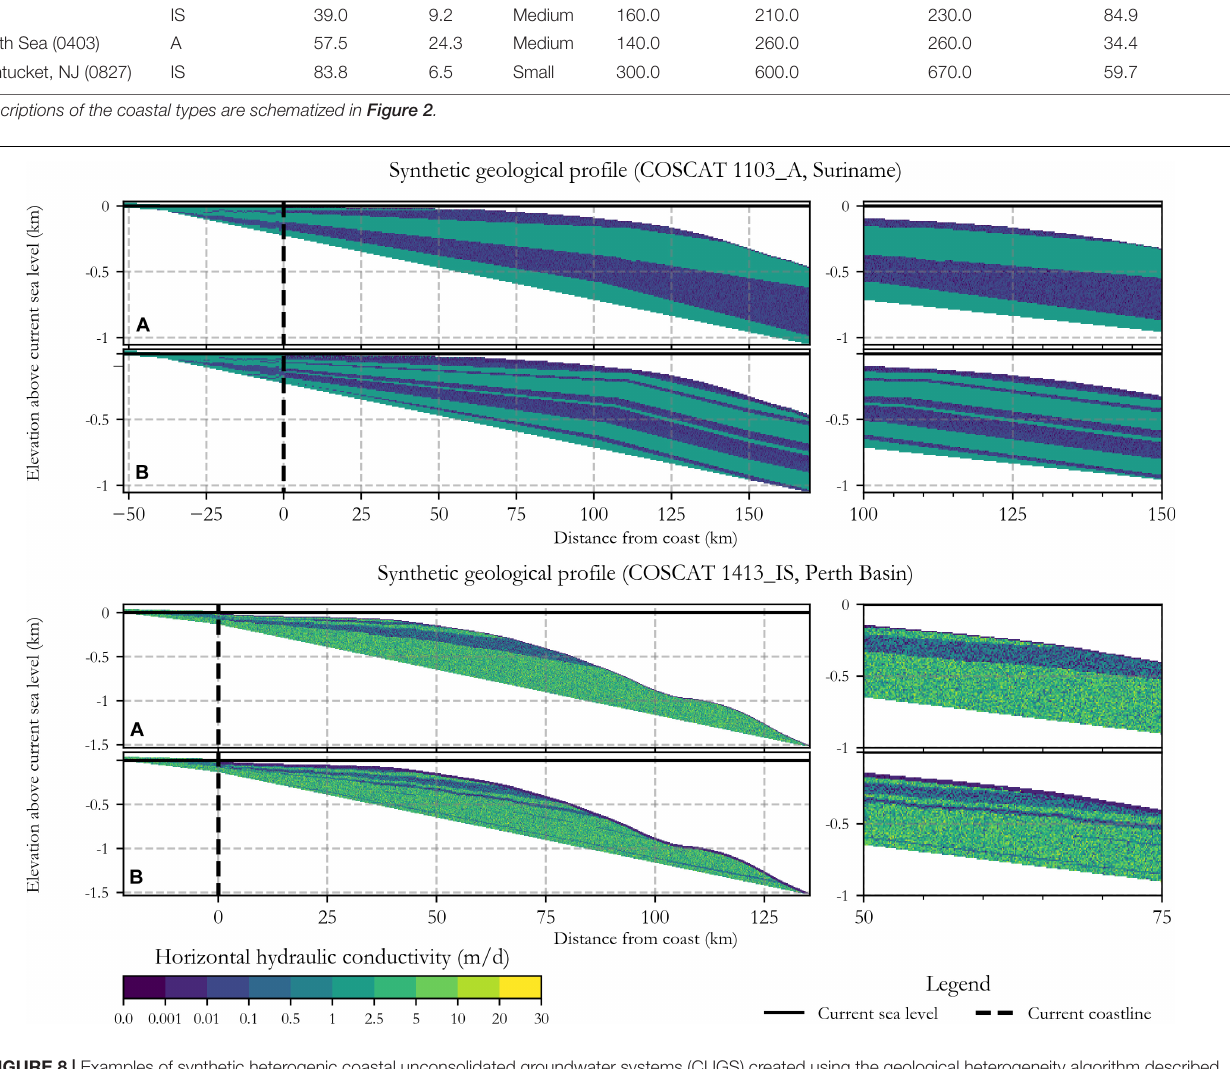
FIGURE 8 | Examples of synthetic heterogenic coastal unconsolidated groundwater systems (CUGS) created using the geological heterogeneity algorithm described in section “Creating Synthetic Heterogenic Parameterization of Coastal Unconsolidated Groundwater Systems (CUGSs).” Randomly generated system with (A) two low and high stand layer combinations and (B) five such layers is presented for each of the two COSCAT regions considered in this